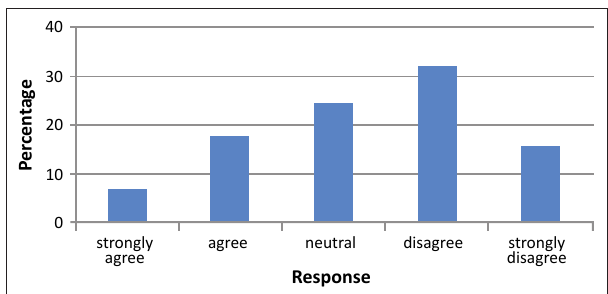
FIGURE 2 : ‘I only read books when I have to’.